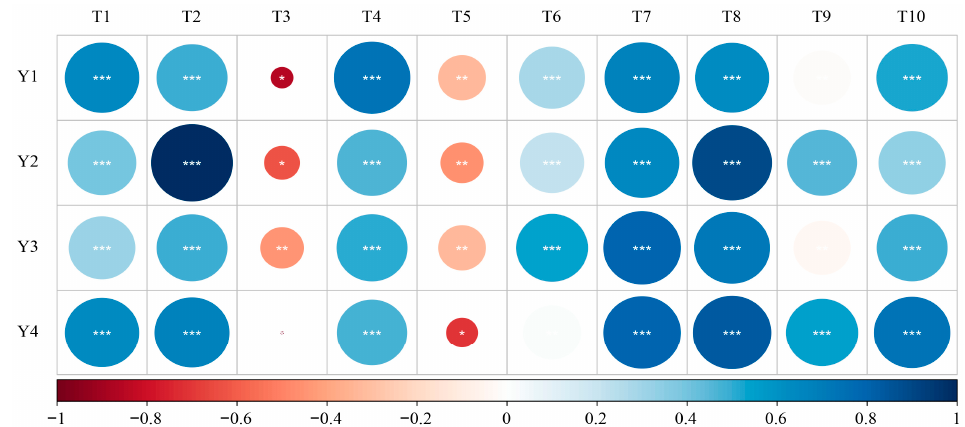
Figure 7. Correlation of dry matter accumulation, nitrogen uptake, and utilization with yield out comes. Y1, grain yield; Y2, number of spikes; Y3, grain number per panicle; Y4, grain weight; T1, photosynthetic rate (P n ) at anthesis; T2, dry matter accumulation; T3, the translocation amount of nitrogen from stem + sheath to grain; T4, the translocation amount of nitrogen from leaf to grain; T5, the translocation amount of nitrogen from glume + spike to grain; T6, recovery efficiency of N fertilizer (RE N ); T7, N partial factor productivity (PFP N ); T8, agronomic N use efficiency (AE N ); T9, physiological N use efficiency (PE N ); T10, nitrogen harvest index (NHI). The darker the color, the higher the correlation. *, **, and *** indicate significant differences at p < 0.05, p < 0.01, and p < 0.001,